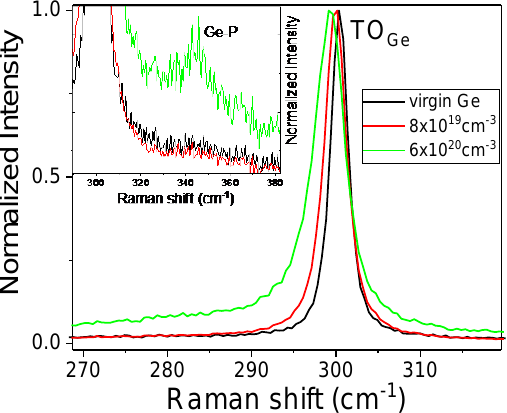
Figure 5. Normalized Raman spectra obtained from intrinsic and P-implanted Ge after FLA for 20 ms. The admixture layer thickness is either 40 or 300 nm and the maximum carrier concentration is 6 × 10 20 cm − 3 and 8 × 10 19 cm − 3 , respectively. The insert shows the enlarged area, where the Ge-P vibrating mode is expected.